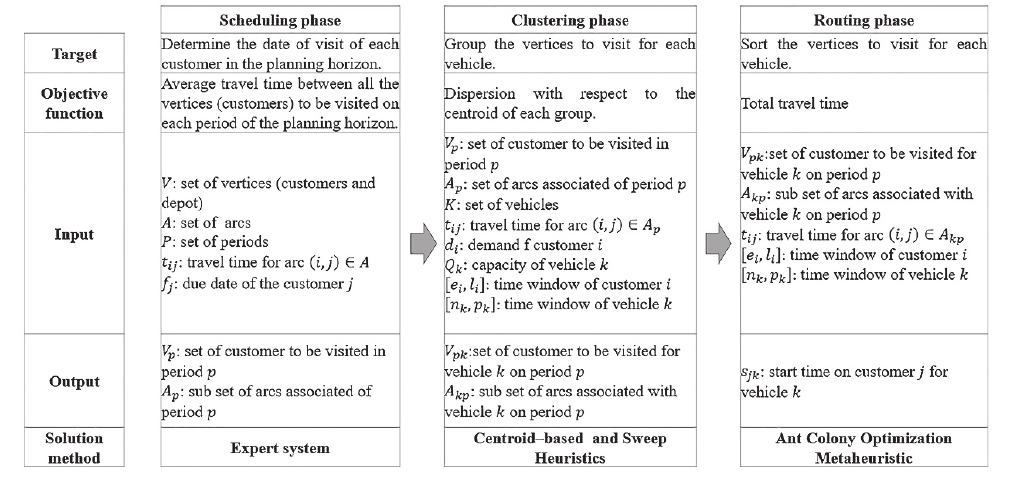
Fig. 1. Proposed solution approach to scheduling and routing in courier